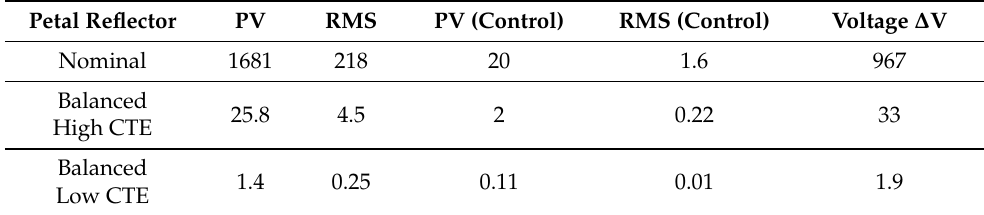
Table 4. Surface figure error of the petal reflector due to a thermal gradient of ∓ 15 ◦ K, before and after control with an array of 120 electrodes. All amplitudes are in µ m and voltages in V. Petal Reflector PV RMS PV (Control) RMS (Control) Voltage ∆ V Nominal 1681